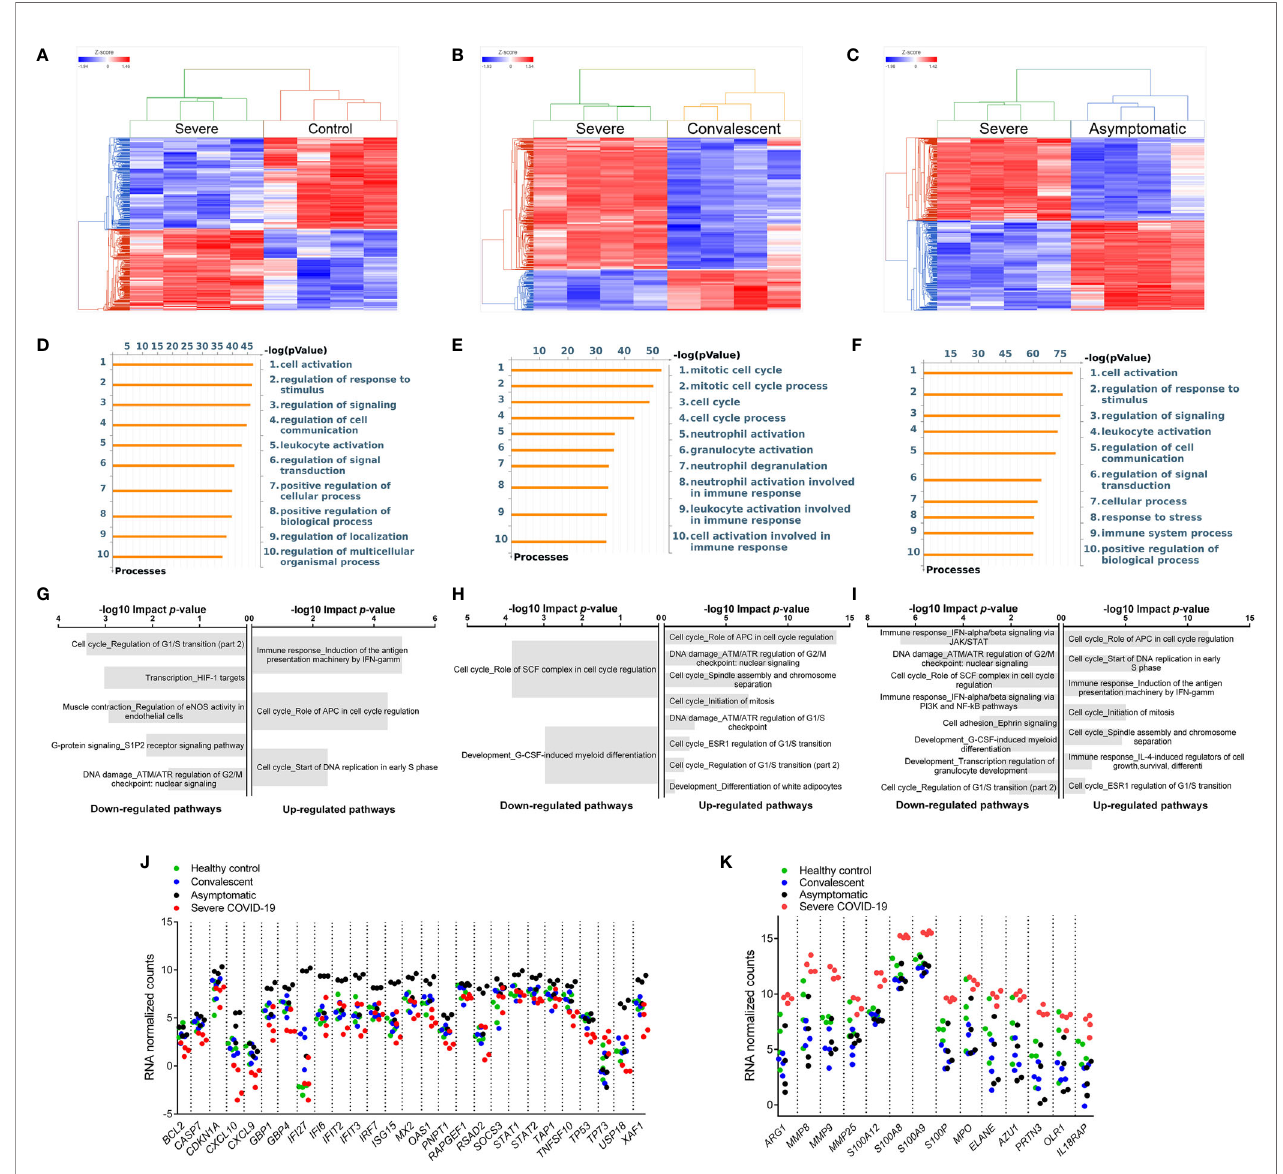
FIGURE 4 | Differential Gene Expression in G-MDSC from Patients and Healthy Controls. Comparison of the transcriptome of puri fi ed G-MDSC using RNAseq from severe (n=4), asymptomatic (n=4), and convalescent (n=4) COVID-19 patients and healthy controls (n=4). (A – C) Dendrograms and Heat-Maps for Unsupervised Hierarchical Clustering comparing transcriptome expression. (D – F) Differences in Gene Ontology Processes identi fi ed by MetaCore in G-MDSC from patients and healthy controls. (G – I) Analysis using Key Pathway Advisor software identi fi ed the Top 25 differentially expressed pathways. (J, K) Dot plots comparing differentially expressed genes of “ Immune response IFNalpha/beta signaling via JAK/STAT ” (J) and Granulocyte Functions and Degranulation (K) in G-MDSC from patients and healthy